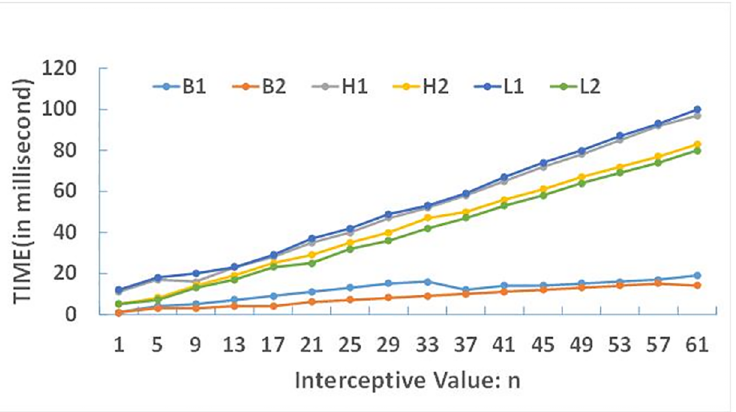
Fig 6. The relationship of time consumption and the interceptive value